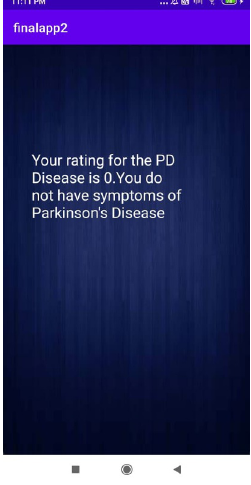
Figure 2: FINAL RESULT OF THE